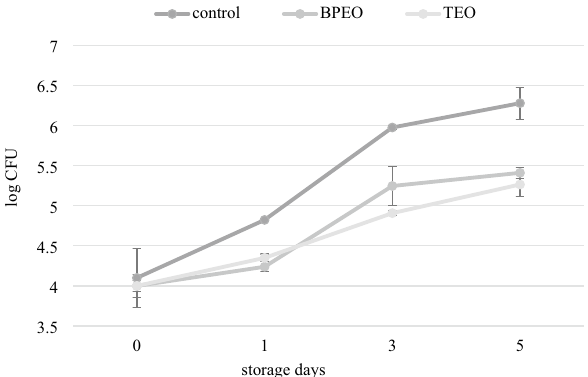
Figure 10. Combined effect of marinade and BPEO/TEO on P. psychrophila KM02 counts in salmon fillets stored at 4 °C in vacuum conditions. Data points represent the mean taken from two replicate experiments and error bars indicate the standard deviations (SD). The statistically differences was provided by Tukey’s test after ANOVA analysis (F = 50.34, p <